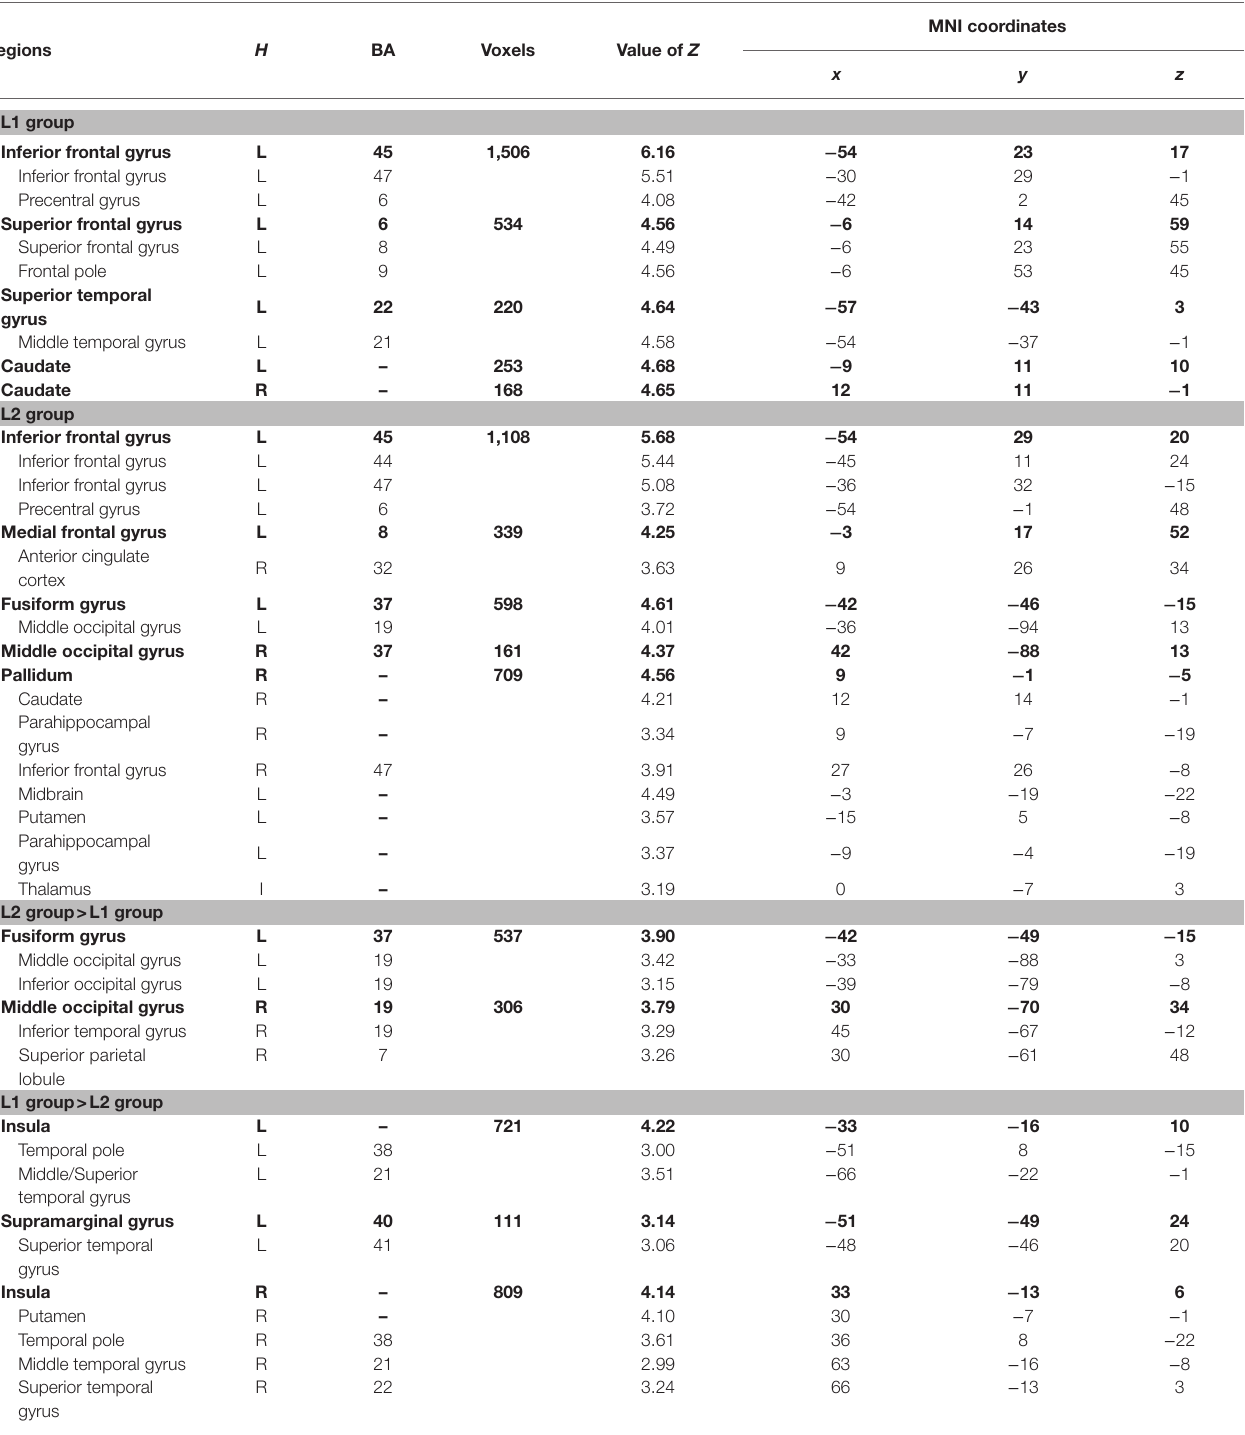
TABLE 1 | Brain regions for the related versus perceptual contrast in the whole-brain analyses. Regions H BA Voxels Value of Z